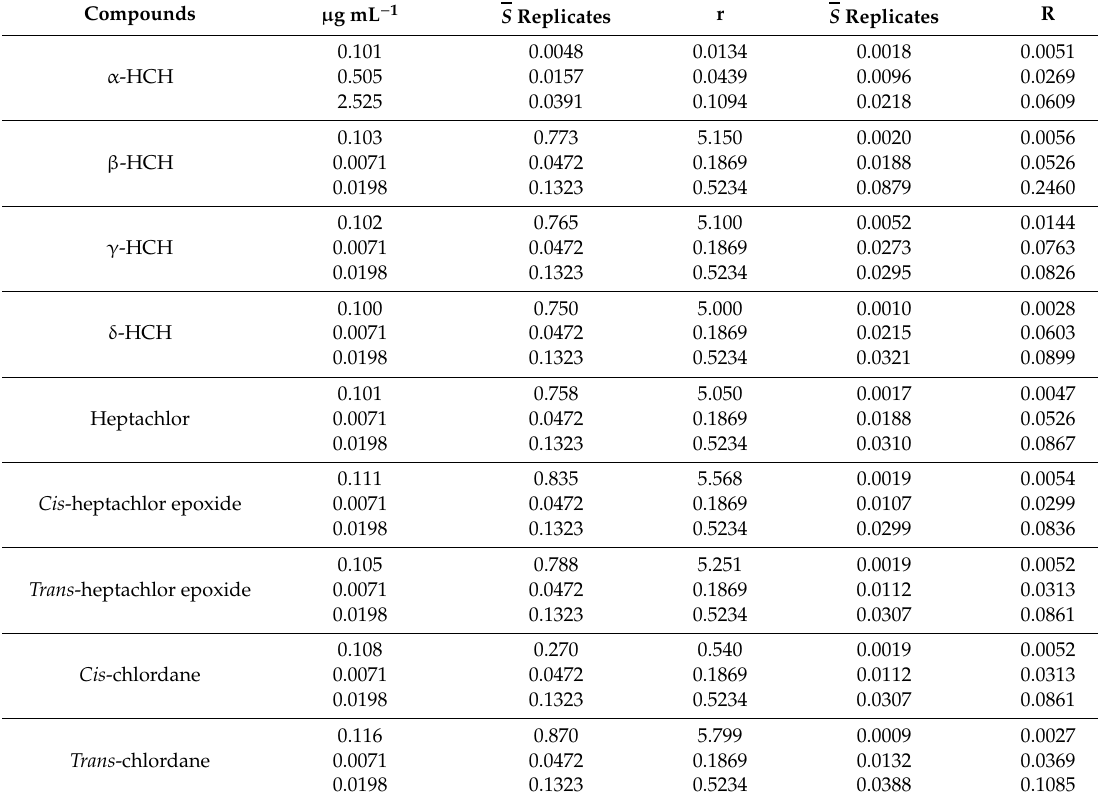
Table 6. Limit of repeatability (r), reproducibility (R) and replicates’ standard deviation averages ( S :) calculated for three concentration